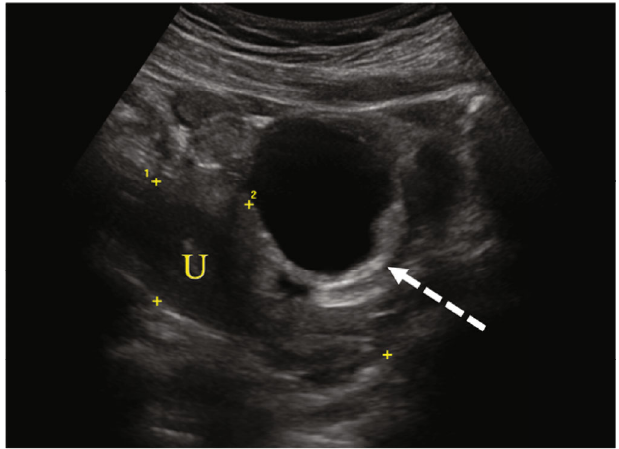
Figure 2: Transabdominal sagittal view demonstrates the uterus outlined in calipers (U). The view anterior to the uterus demonstrates an anechoic simple cyst. The dashed white arrow demonstrates a hyperechoic rim of displaced ovarian parenchyma with a paucity of